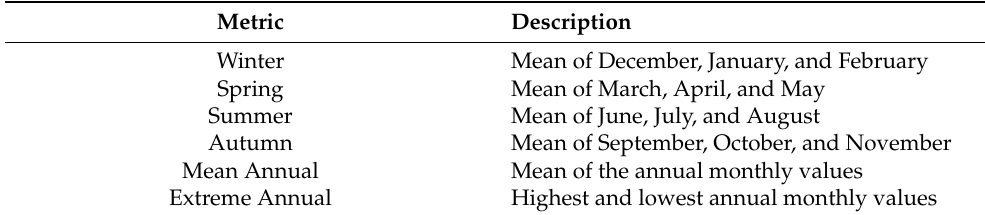
Table 1. Summary of microclimatic and refugial capacity metrics built for Tn, Tx, and VPDmax, based on a year-type (36 months for air metrics, and at least one year for soil